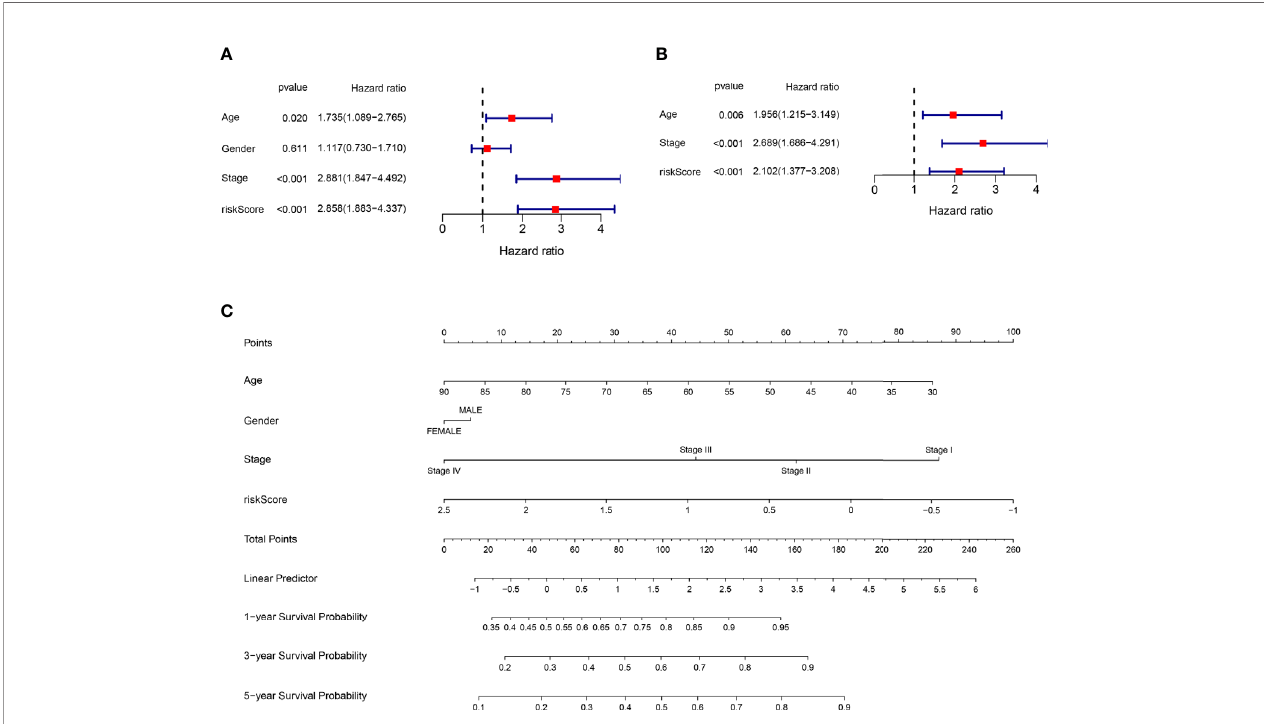
FIGURE 4 | Riskscore and other clinical pathology characters synergistically predicted the survival probability of colon cancer patients. (A) Univariate cox regression analysis of age, gender, stage, and riskscore in the TCGA cohort. Riskscore is signi fi cantly associated with the survival of colon cancer patients. (B) Multivariate cox regression analysis of age, stage, and riskscore in the TCGA cohort. Riskscore is an independent prognostic factor for the survival of colon cancer patients. (C) Nomogram for the prediction of 1-, 3-, and 5-year survival probability in patients with colon